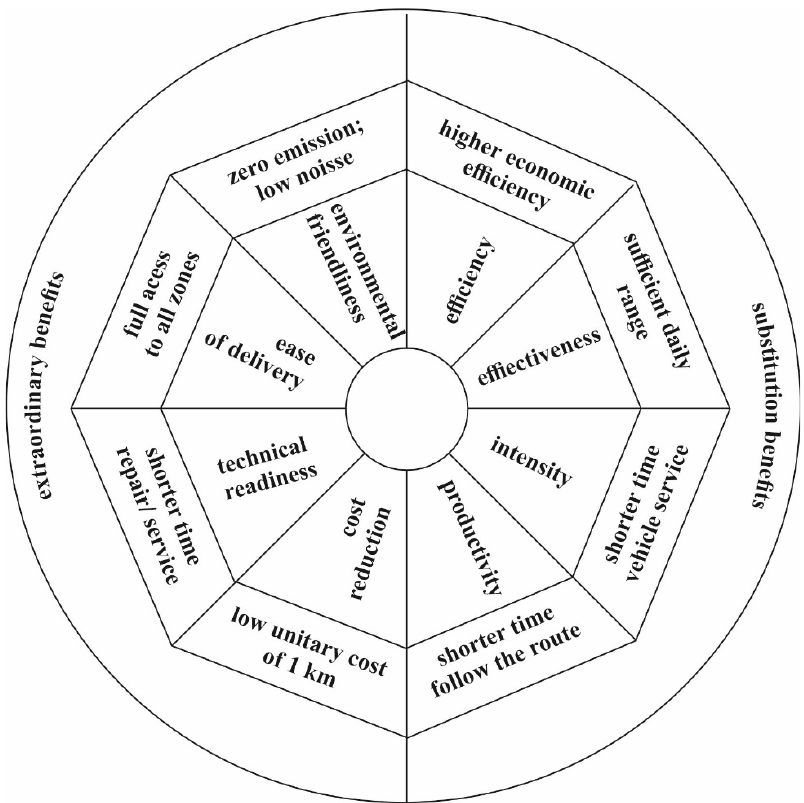
Figure 12. Model of „Electromobility Octagon Profit” for light commercial vehicles with electric current drive. Source: Own